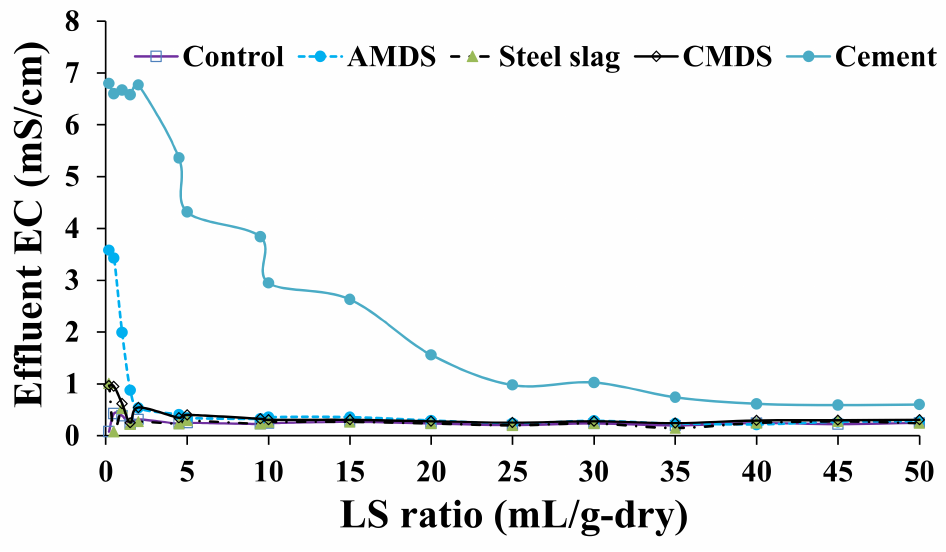
Figure 3. Eluate curves of the electric conductivity (EC) as a function of L/S ratio by the column percolation test comparing different stabilized soils.